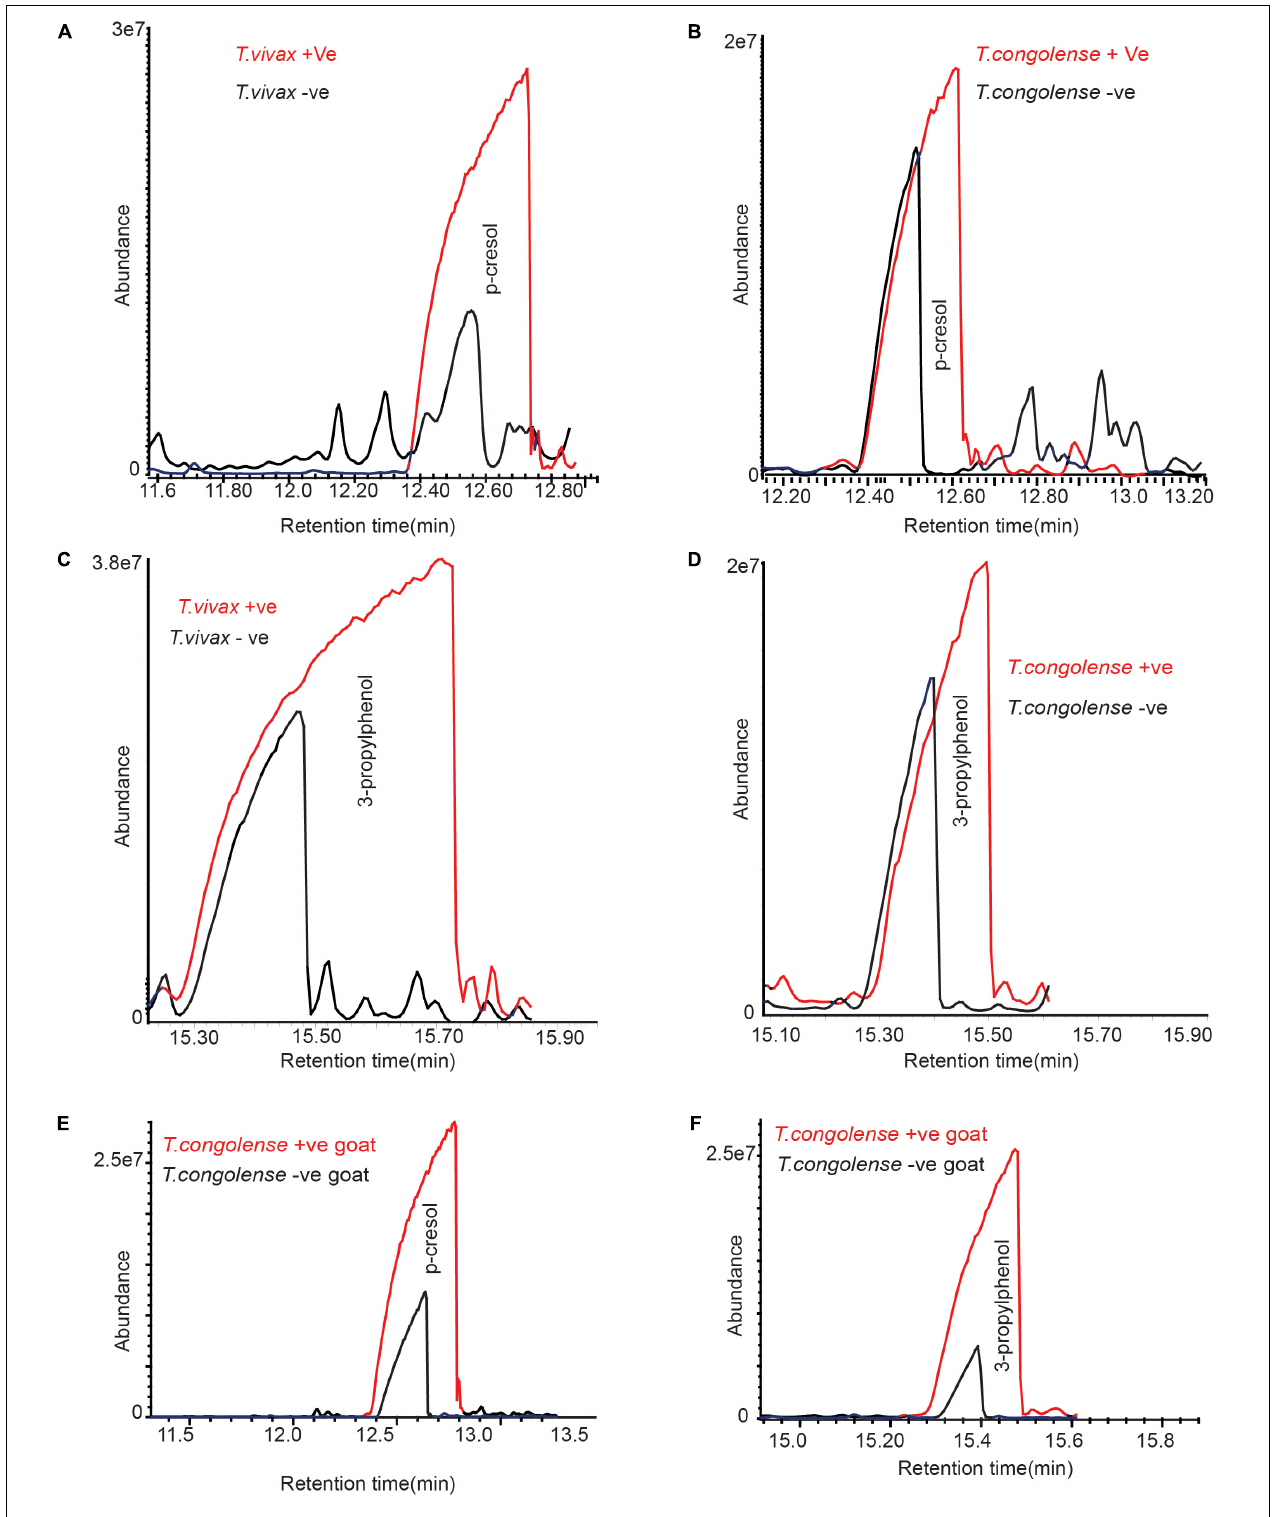
FIGURE 5 | Trypanosome infection increased phenolic compounds concentration in cow urine. (A–D) Representative GC-MS profile showing the significant increase of phenolic compounds due to T. congolense and T. vivax infection. (E,F) Representative GC-MS profile showing the significant increase of phenolic compounds due to T. congolense in goat urine. Panel (A) is for T. congolense and (B) is for T. vivax infection. Due to the variation of metabolites modification between individual livestock, the graphs are not presented at the same scale.